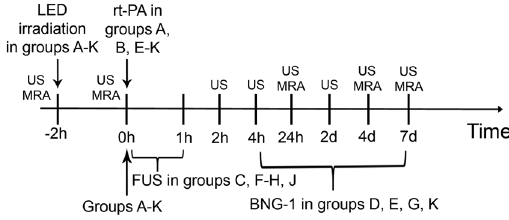
Figure 5. Schema of the experimental design. Seven treatment groups (n = 6–8 in each group) are examined including (A) intravenous bolus injection of 0.45 mg/kg rt-PA (low-dose), (B) intravenous bolus injection of 0.9 mg/kg (standard-dose, n = 8), (C) sonothrombolysis with focused ultrasound (FUS) alone, (D) oral administration of 2 g/kg BNG-1 alone for 7 days, (E) combination of A and D, (F) combination of A and C (n = 8), and (G) combination of A, C and D. Another 4 groups are made for comparison including (H) 0.45 mg/kg rt-PA 20% bolus + 80% IV fusion + FUS, (I) 0.9 mg/kg rt-PA with 10% bolus + 90% intravenous fusion, (J) combination of B and C, (K) combination of B and D. US = small-animal carotid ultrasound study. MRA = magnetic resonance angiography